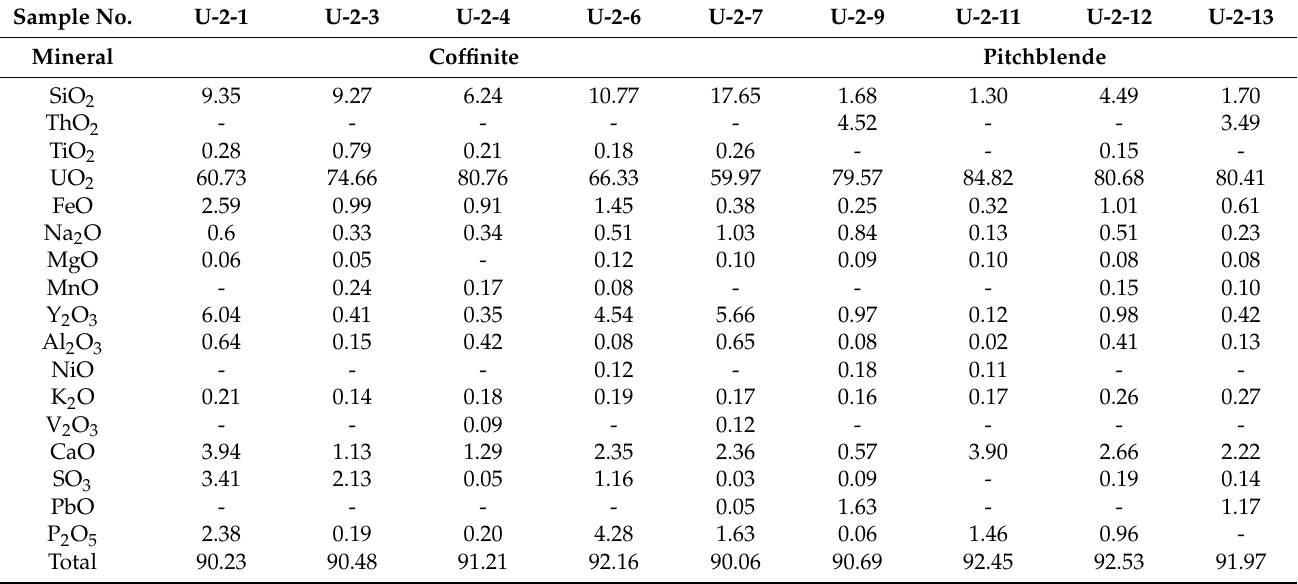
Table 3. Results of the electron microprobe analysis of uranium minerals in the Yuqia uranium occurrences